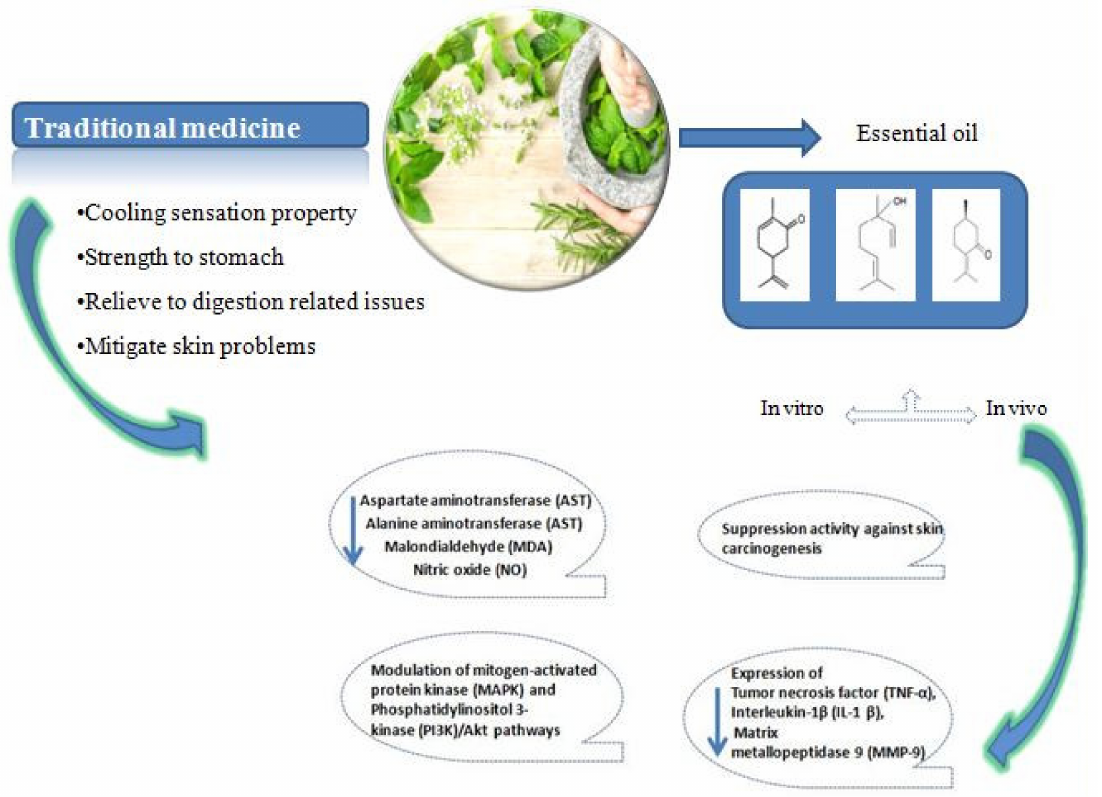
Figure 1. Summary of the main effects of Mentha